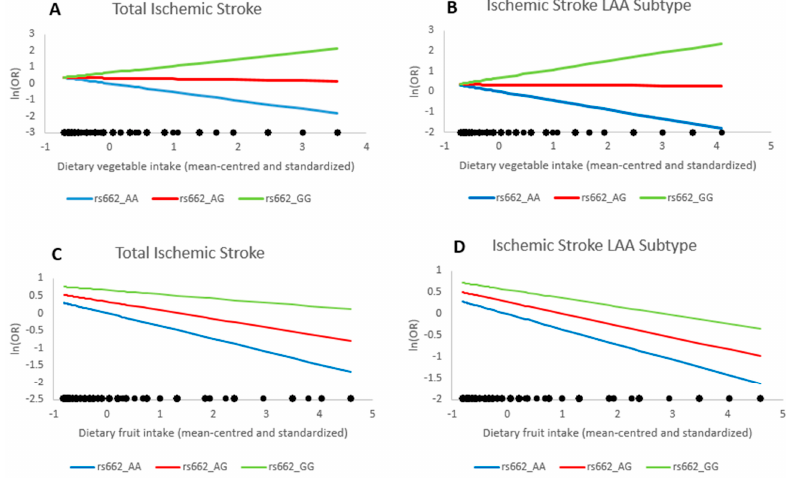
Figure 1. Interactions between PON1 rs662_G allele numbers and standardized vegetable or fruit intake for total ischemic stroke and LAA. Interactions between PON1 rs662_G allele count and vegetable intake for total ischemic stroke ( A ) and LAA ( B ) and interactions between PON1 rs662_G allele count and fruit intake for total ischemic stroke ( C ) and LAA ( D ). Blue line represents those who are homozygous for the A allele (A/A), red line represents heterozygous (A/G), and green line represents homozygous for the G allele (G/G). The Y -axis shows the natural log transformed ORs. The X -axis shows the mean-centered and standardized intake levels of vegetable or fruit (participants with the highest and lowest 1% of vegetable intake levels were excluded to minimize the potential impact of outliers). LAA, large artery atherosclerosis; OR, odds